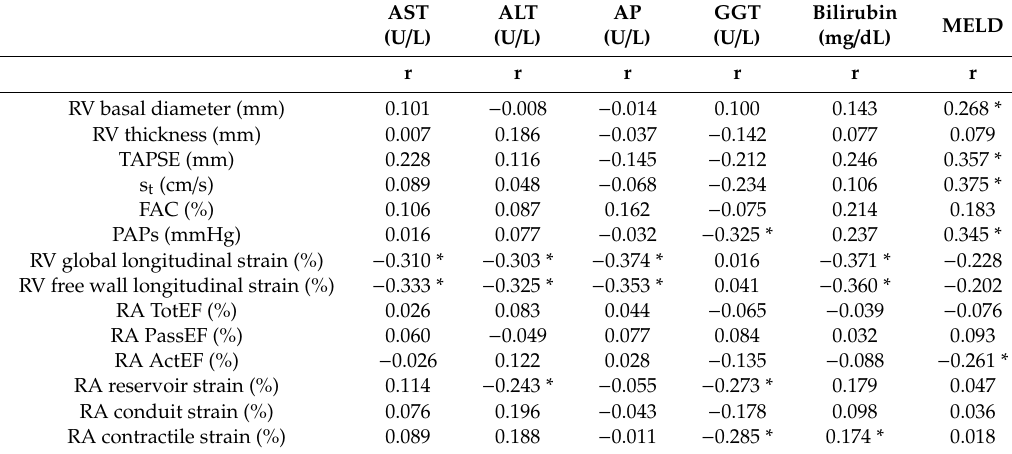
Table 4. Correlation analysis in the patients with